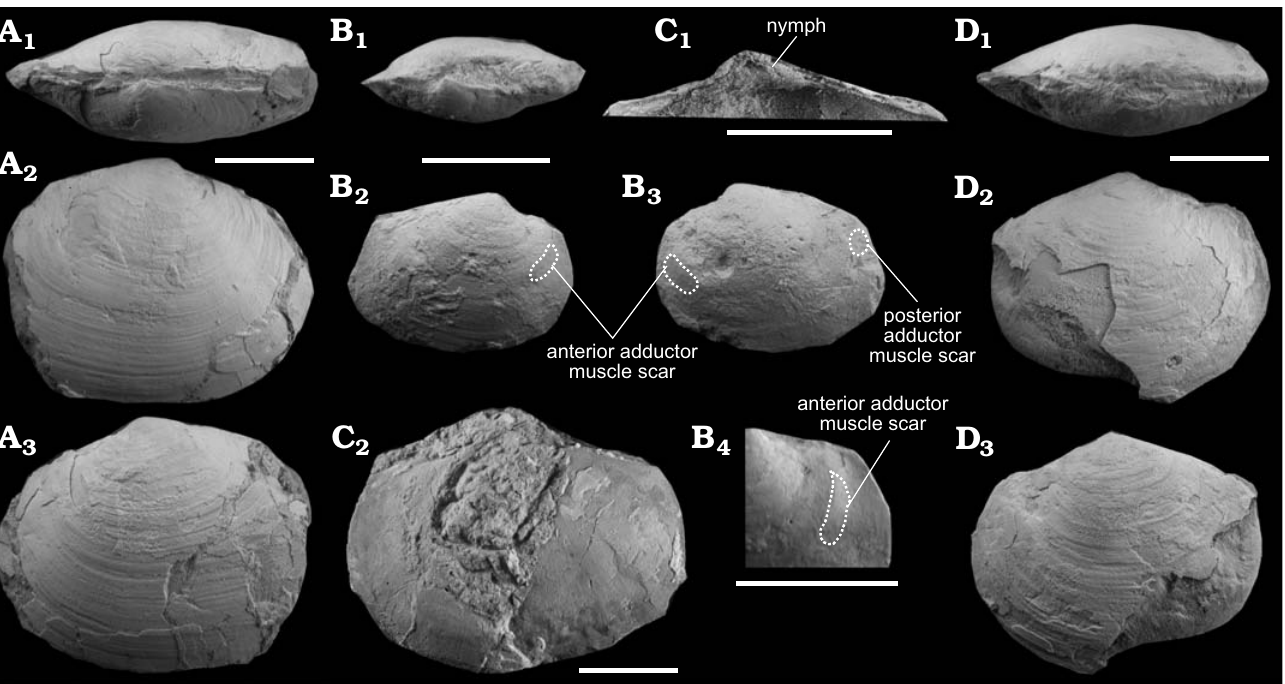
Fig. 4. Lucinid bivalve Elliptiolucina neozelandica sp. nov. from the middle Miocene Bexhaven Limestone at Moonlight North (A, Y16/f1174; B–D, Y16/1059), North Island, New Zealand. A . UOA L4771 (holotype), dorsal view (A 1 ), right (A 2 ) and left (A 3 ) valves. B . UOA L4783 (paratype), dorsal view (B 1 ), right valve (B 2 ), internal mould of left valve (B 3 ), enlargement of anterior adductor muscle scar in B 2 (B 4 ). C . UOA L4775 (paratype), edentulous hinge plate of right valve (C 1 ), left valve (C 2 ). D . UOA L4774 (paratype), dorsal view (D 1 ), right (D 2 ) and left (D 3 ) valves. Scale bars 10 mm.